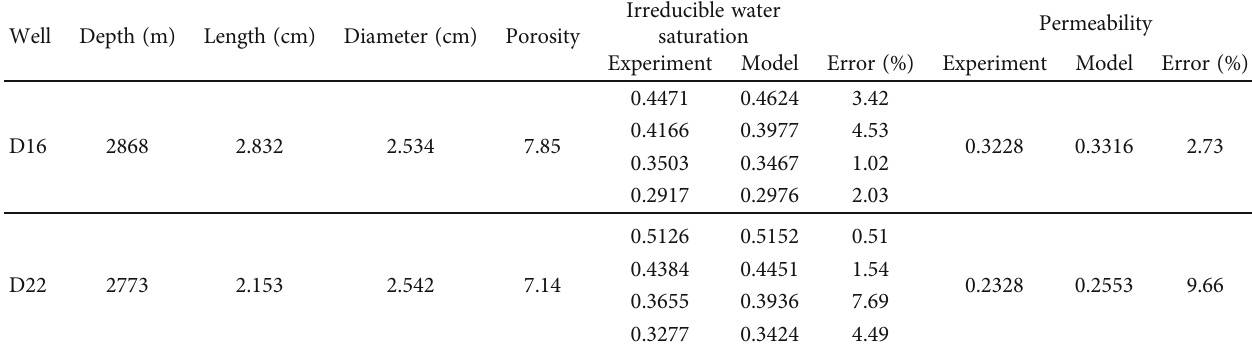
Table 1: Comparison of results between core experiment and